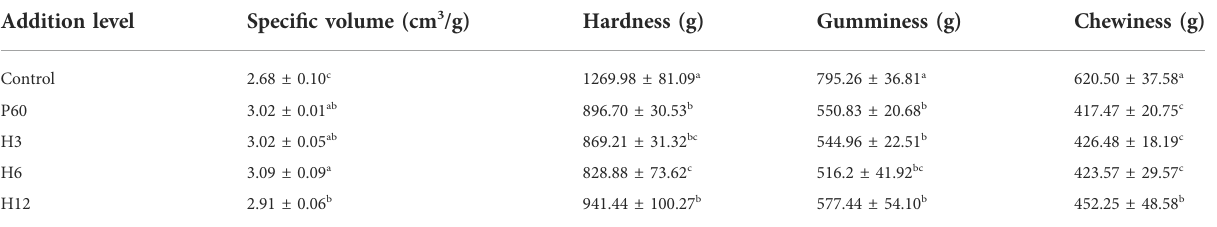
TABLE 1 The effects of Hmxyn on quality of wholewheat